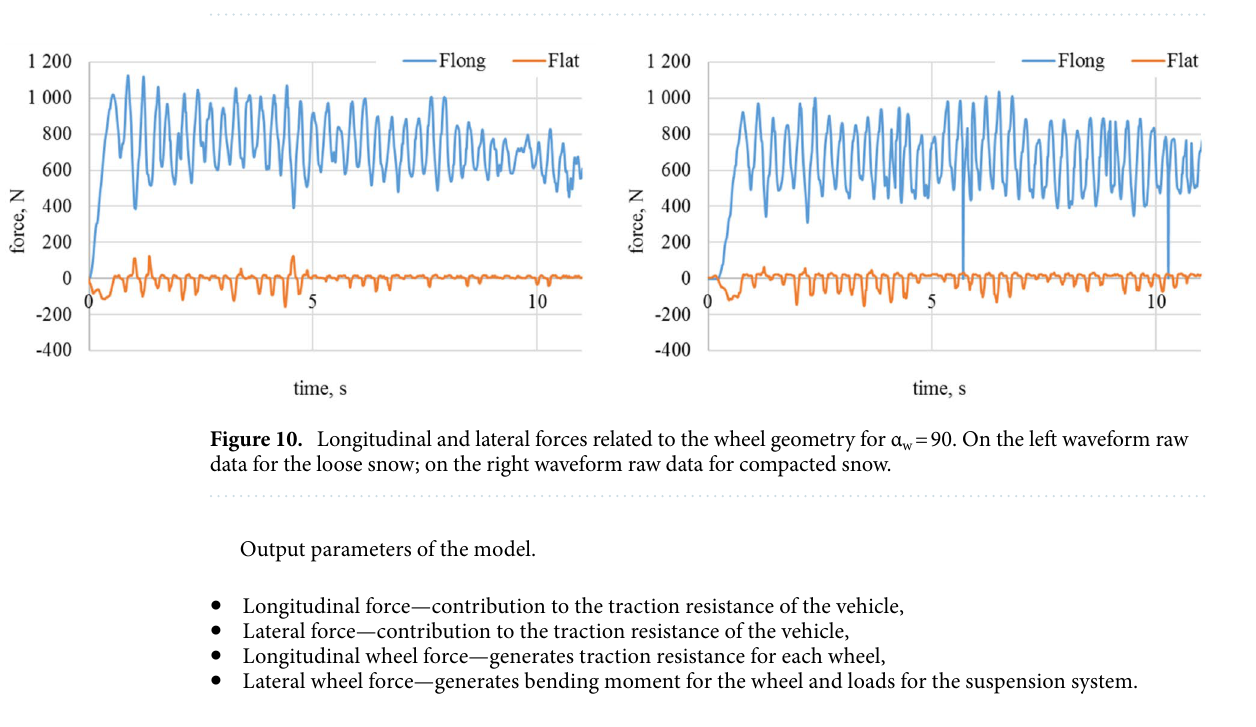
Figure 9. Longitudinal and lateral forces related to the wheel geometry for α w = 90°. On the top left waveform: dry granite; on the top right waveform: wet granite. On the bottom left waveform: loose snow; on the bottom right waveform: compacted snow.